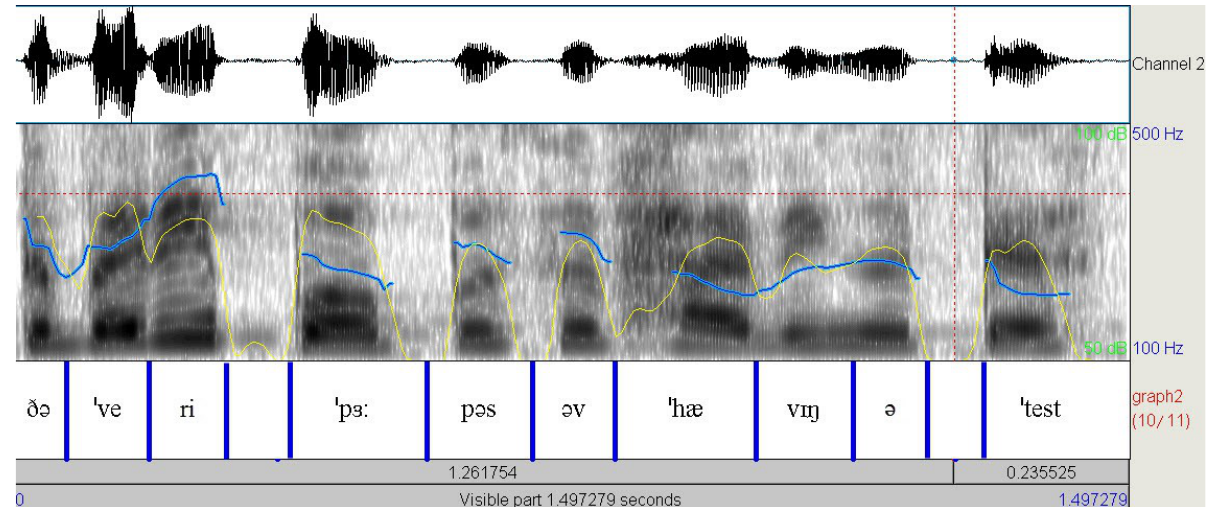
Fig. 2 – F0 contour in the utterance produced by an IE female speaker Notes: blue curve signifies F0; yellow curve signifies intensity